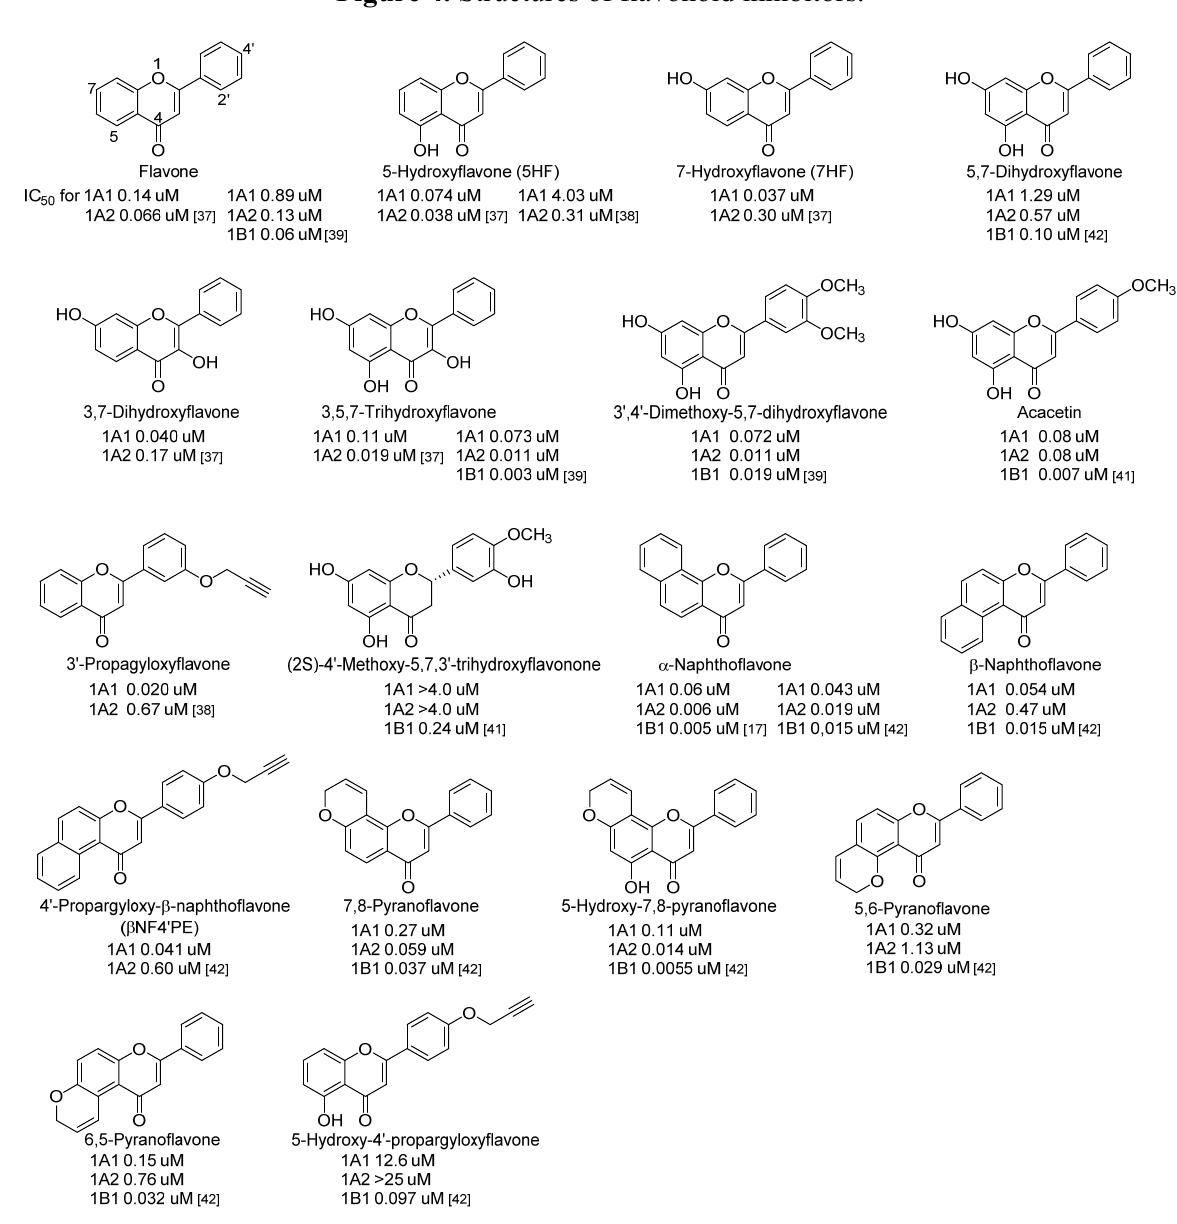
Figure 4. Structures of flavonoid